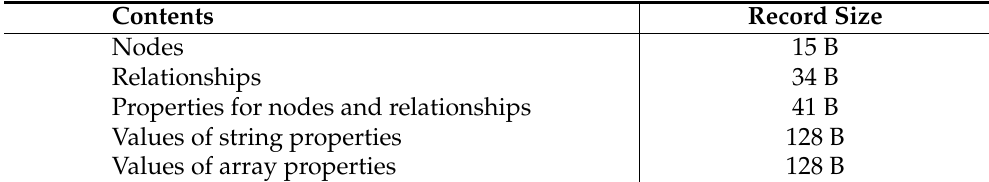
Table 1. Memory efficiency for